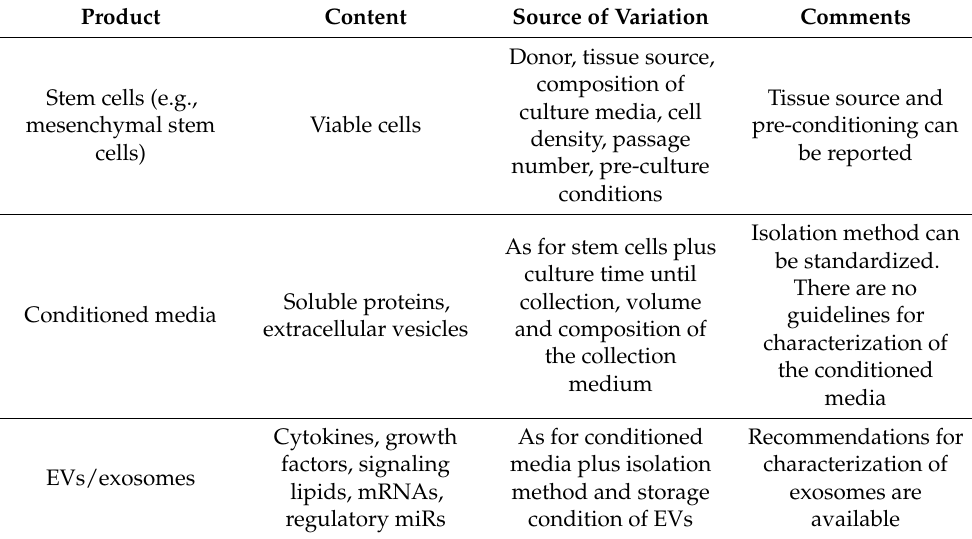
Table 3. List of MSCs and MSC-derived products with content, sources for variations and comments regarding